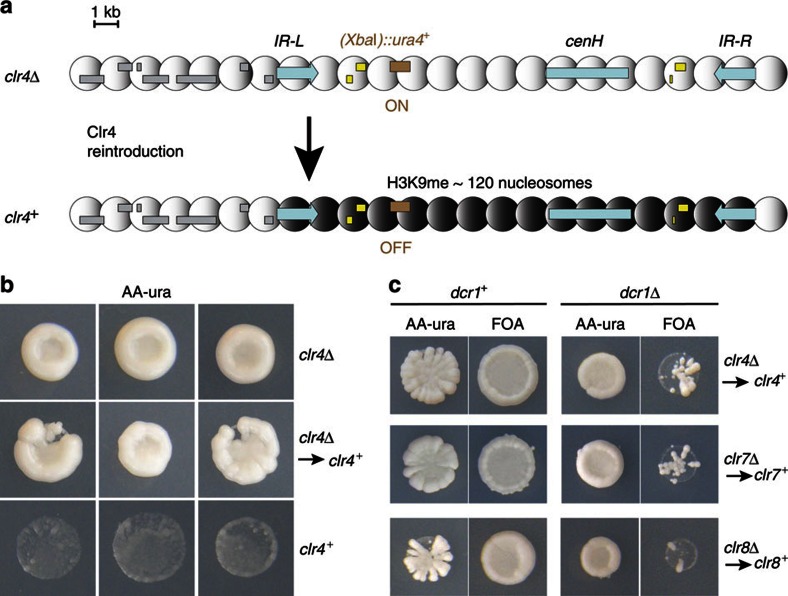
Slow establishment of heterochromatic silencing by the H3K9 methyltransferase Clr4.(a) Mating-type region. Nucleosomes between the IR-L and IR-R boundaries are methylated by Clr4, silencing gene expression. The chromosomal location of the (XbaI)::ura4+ reporter is shown. cenH: ∼4.2 kb region with centromere homology; grey boxes: ORFs; yellow boxes: silent mating-type information at mat2-P and mat3-M. (b) de novo silencing of (XbaI)::ura4+ by Clr4. Colonies formed by spores on rich medium were replicated onto medium lacking uracil. All colonies shown contain the (XbaI)::ura4+ reporter. A phenotypic gap is observed following re-introduction of clr4+into clr4Δ cells (middle panels) allowing clr4+cells to grow in the absence of uracil. The three colonies shown on the last row (clr4+) are genetically identical to the colonies above them (clr4Δ to clr4+) but their heterochromatin is fully established. (c) Dicer facilitates the establishment of heterochromatic silencing by Clr4, Clr7 and Clr8. Wild-type alleles were re-introduced into deletion strains by genetic crosses as indicated. Silencing of (XbaI)::ura4+ permits growth on 5-fluoroorotic acid (FOA). Establishement of (XbaI)::ura4+ silencing is more efficient in the dcr1+ than in the dcr1Δ progeny of each cross.